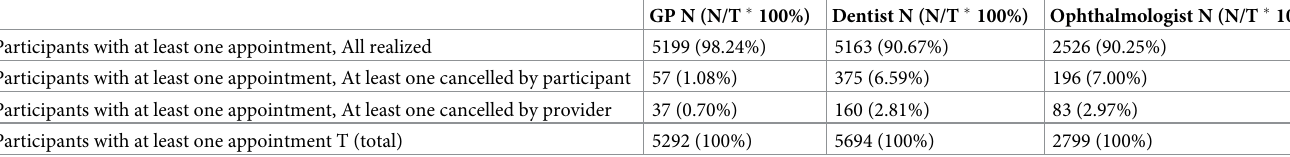
Table 1. Comparison of appointment status for GP, dentist and ophthalmologist.